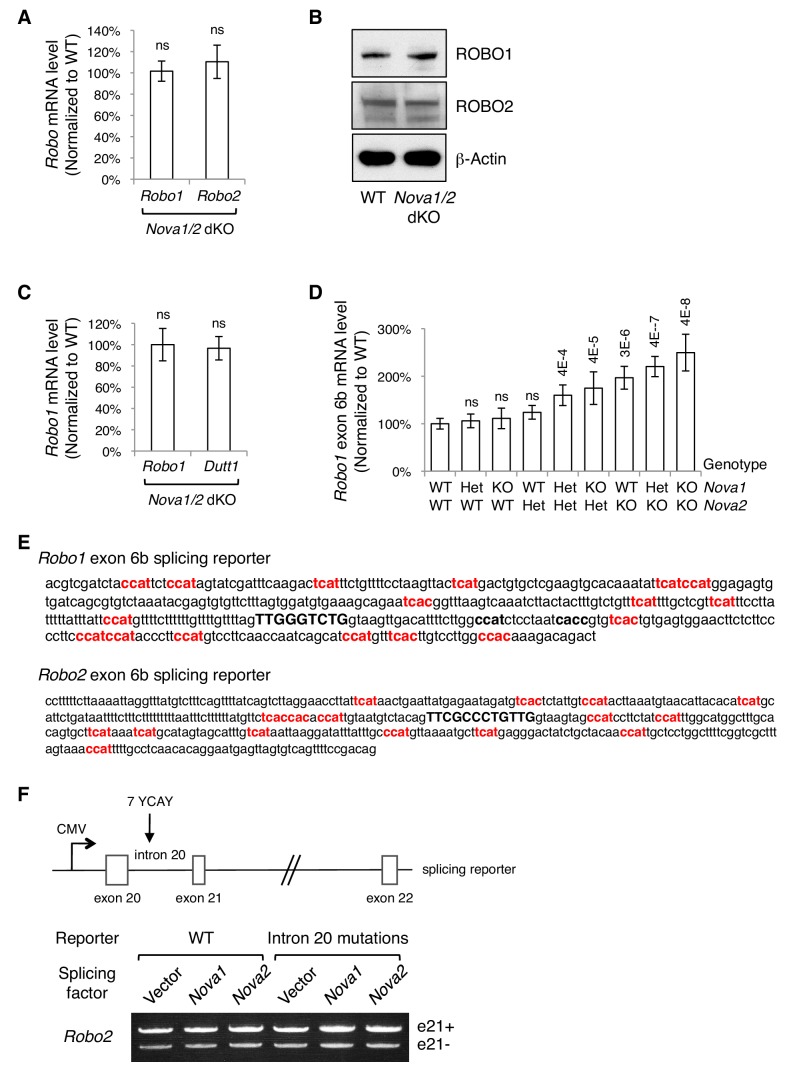
Alternative splicing of Robo1/2.(A) Quantitative RT-PCR of a constitutive exon in Robo1/2 showing the total Robo mRNA levels in Nova1/2 dKO dorsal spinal cord at E11.5. (B) Western blotting analysis of ROBO1/2 protein levels in E11.5 spinal cords. The antibodies do not distinguish between the alternative isoforms. (C) Quantitative RT-PCR analysis of Robo1 and Dutt1 levels in Nova1/2 dKO dorsal spinal cord, which are two alternative mRNAs produced from two different promoters (Nural et al., 2007),. Other alternative 5’ sequences of Robo1 and Robo2 were also tested and no significant difference was observed between WT and Nova1/2 dKO spinal cords. (D) Quantification of Robo1 exon 6b expression in nine different genotype combinations of Nova1 and Nova2. Robo1 exon 6b level was sensitive to Nova1/2 gene copy number. Robo2 exon 6b level was regulated in a similar dose-sensitive manner. Data are normalized to the WT and are represented as the mean ± SD (Student’s t-test in A,C; one-way ANOVA and Bonferroni post test in D; n = 3 for all genotypes; p value are indicated; ns, not significant). (E) Genomic DNA included in exon 6b splicing reporters. Exon 6b sequences are capitalized and in bold. Potential NOVA-binding sites (YCAY repeats; Y = C/U) that were mutated in the splicing assays are in bold and in red. Two additional candidate NOVA-binding sites (in black, bold, and lower case) are present in Robo1 intron 6b but were not mutated, as the mutations themselves constitutively repressed exon 6b inclusion. (F) Splicing assays of Robo2 exon 21. Schematic shows the Robo2 exon 21 splicing reporter, which contains the complete genomic sequences between exons 20 and 22 (5.8 kb). Candidate NOVA-binding sites (7 YCAY repeats) are located in intron 20. Expression of e21- and e21+ isoforms was detected by semi-quantitative RT-PCR. NOVAs had no direct effect on Robo2 exon21 alternative splicing.